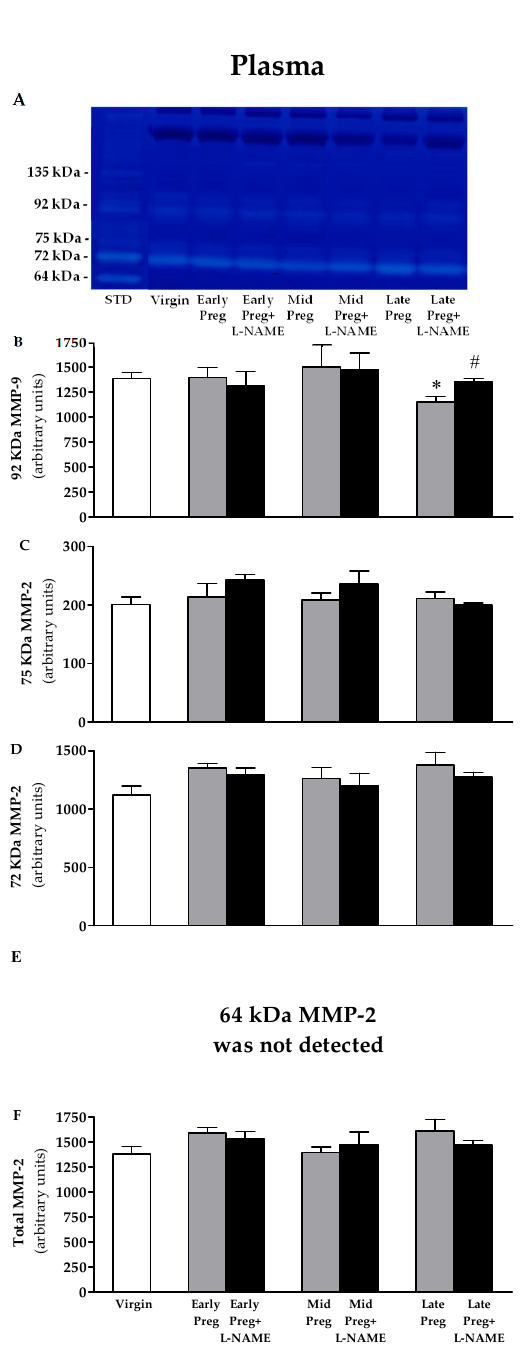
Figure 4. Representative zymography gel from the plasma ( A ). Gelatinolytic activity of 92 KDa MMP-9 ( B ), 75 KDa MMP-2 ( C ), 72 KDa MMP-2 ( D ), 64 KDa MMP-2 was not detected ( E ) and total MMP-2 ( F ) in virgin rats and Early, middle (Mid) and Late-pregnant rats treated with saline or L-NAME. Values represent mean ± SEM. * P < 0.05 versus the Virgin group, # P < 0.05 versus the Late-Preg group.